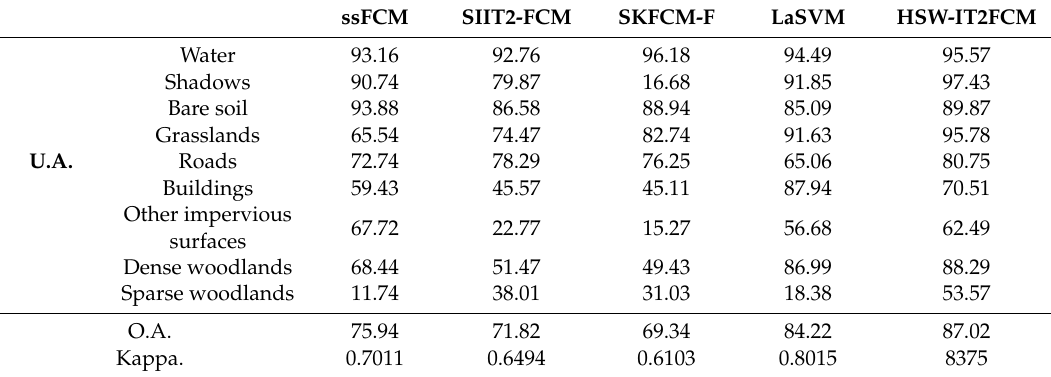
Table 5. The U.A. (%), O.A. (%) and Kappa coe ffi cients of five